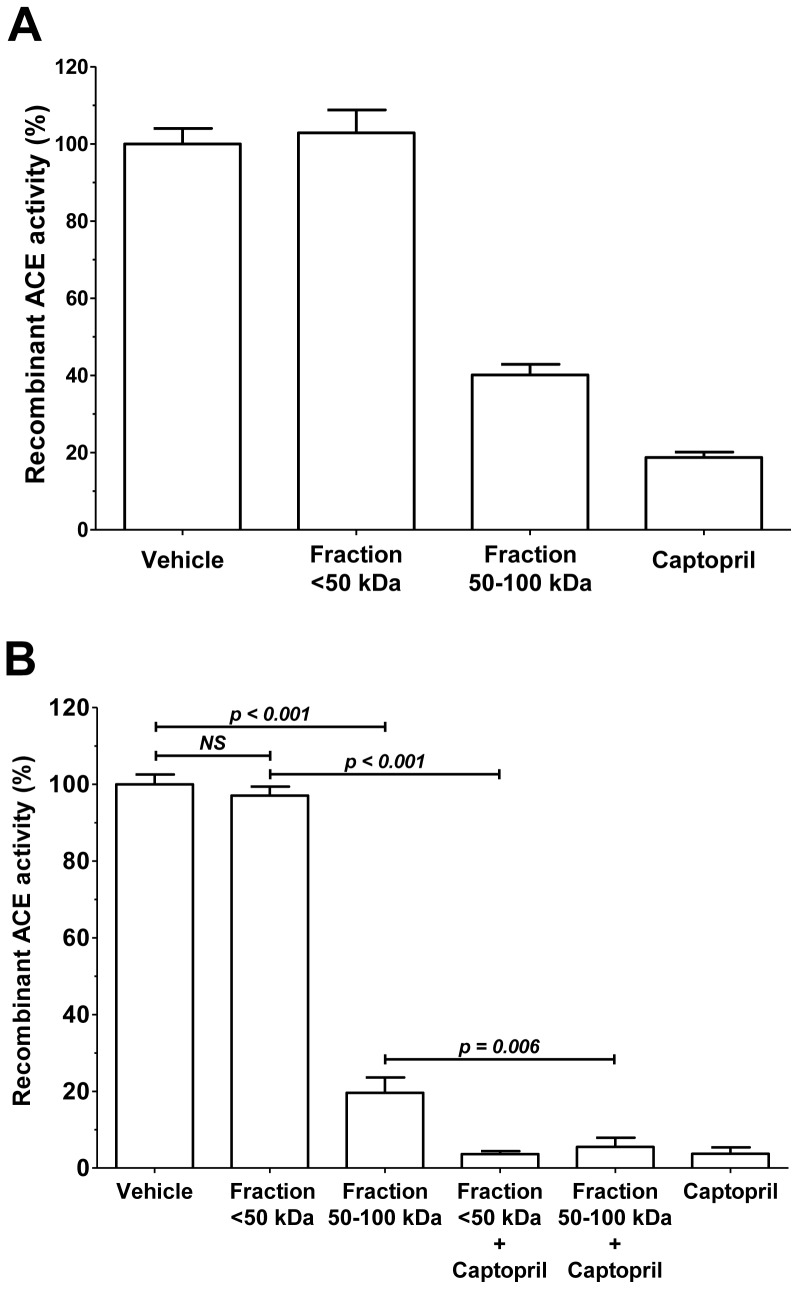
Efficacy of the ACE inhibition by human serum fractions and captopril.Inhibition of recombinant ACE was measured alone (vehicle) or in the presence of four-fold diluted human serum fractions containing components below 50 kDa (<50 kDa), in the range of 50–100 kDa and 1 µM captopril. Experiments were done first using the physiological substrate angiotensin I (A). Bars represent means ± SD of 2 independent determinations, values are expressed in the percentage of vehicle. The effects were also determined using the artificial substrate FAPGG (B). In this latter case serum fractions were also combined with captopril (<50 kDa+captopril and 50–100 kDa+captopril), in addition to the above mentioned conditions (<50 kDa, 50–100 kDa and 1 µM captopril). Bars represent means ± SD of 3 independent determinations, values are given in the percentage of vehicle, significant differences are indicated by p values.